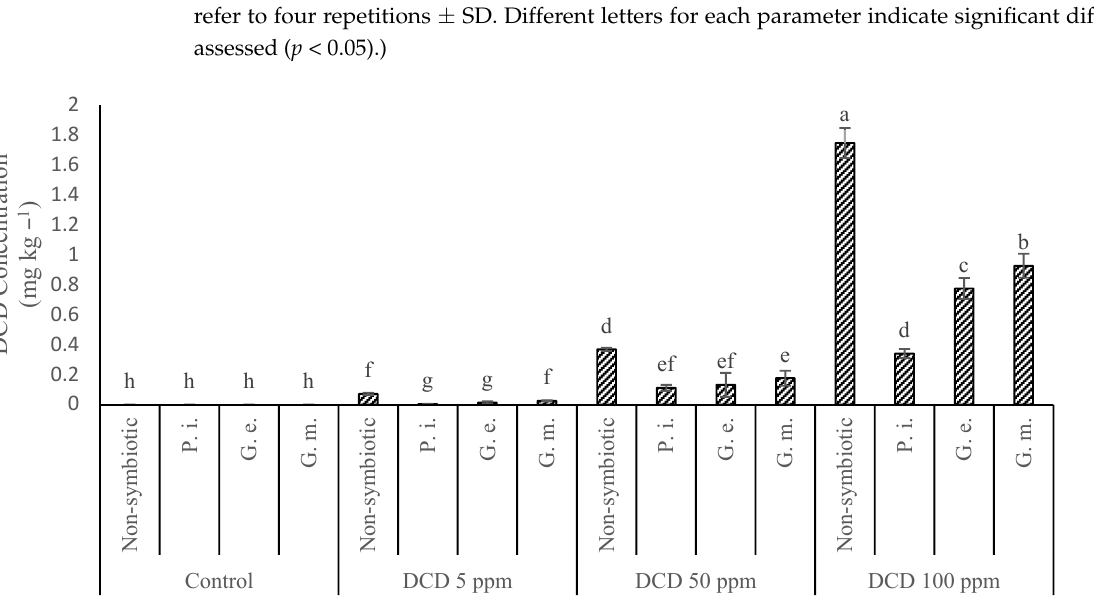
Figure 7. Effect of Piriformospora indica, Glomus mosseae , and Glomus etunicatum on the dicyandiamide content under different concentrations of dicyandiamide nitrification inhibitor in lettuce. (The means refer to four repetitions ± SD. Different letters for each parameter indicate significant differences assessed ( p < 0.05).)